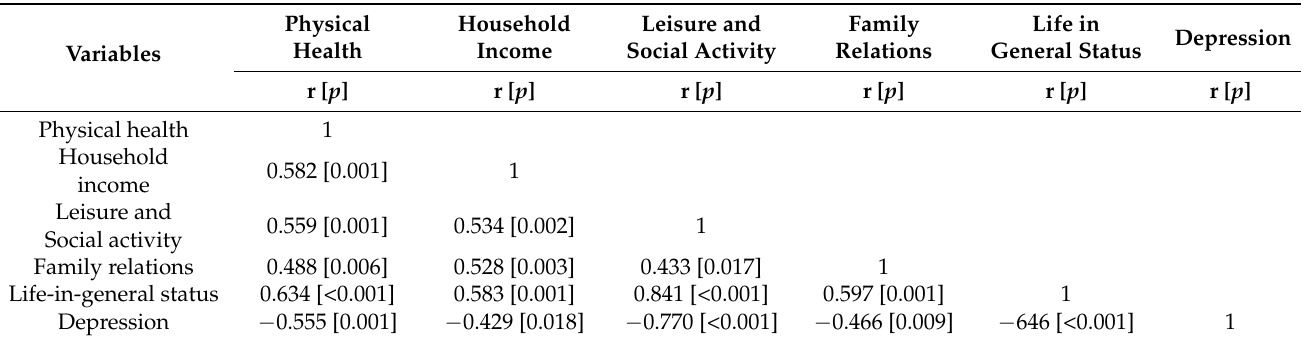
Table 4. Correlation of physical health, household income, leisure and social activity, family relations, and life-in-general status in caregiver.